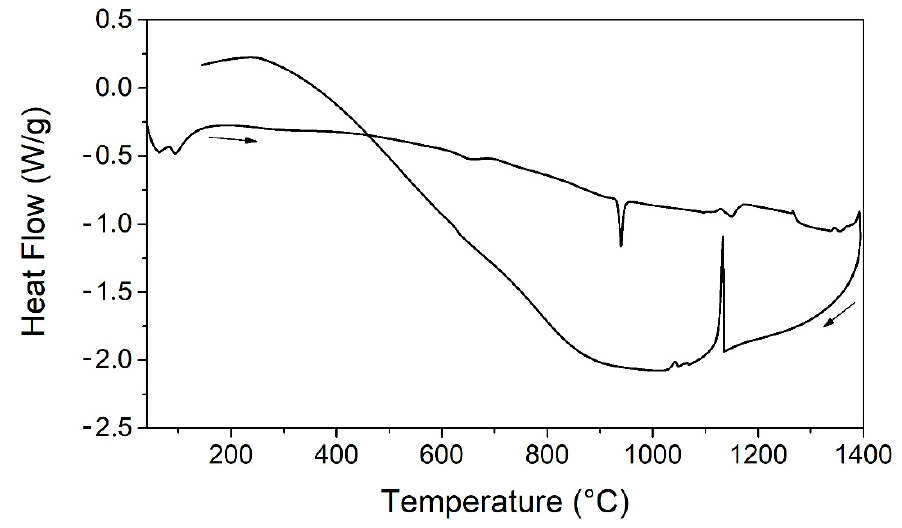
Figure 1. Heat flow vs. temperature up to 1400 °C for the as-cast material (sample